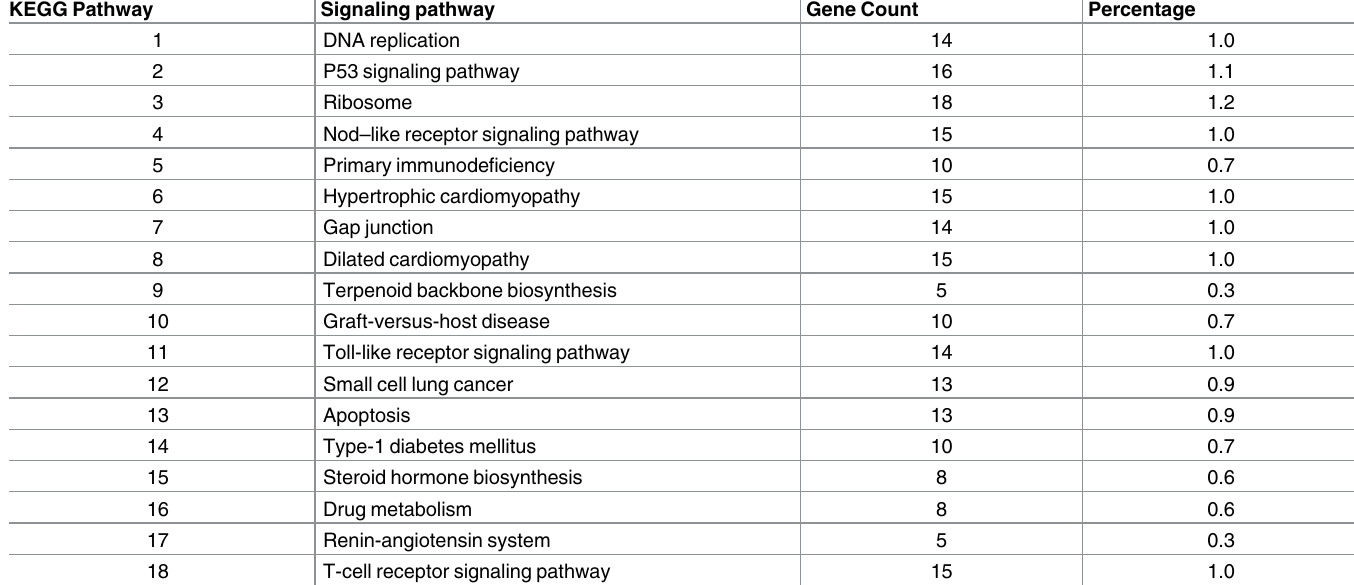
Table 4. Signaling pathways that are unique to day 28 with heavy CaOx crystaldeposition (Nephrolithiasis) when compared with day 14 (Hyperox- aluric condition). KEGG Pathway